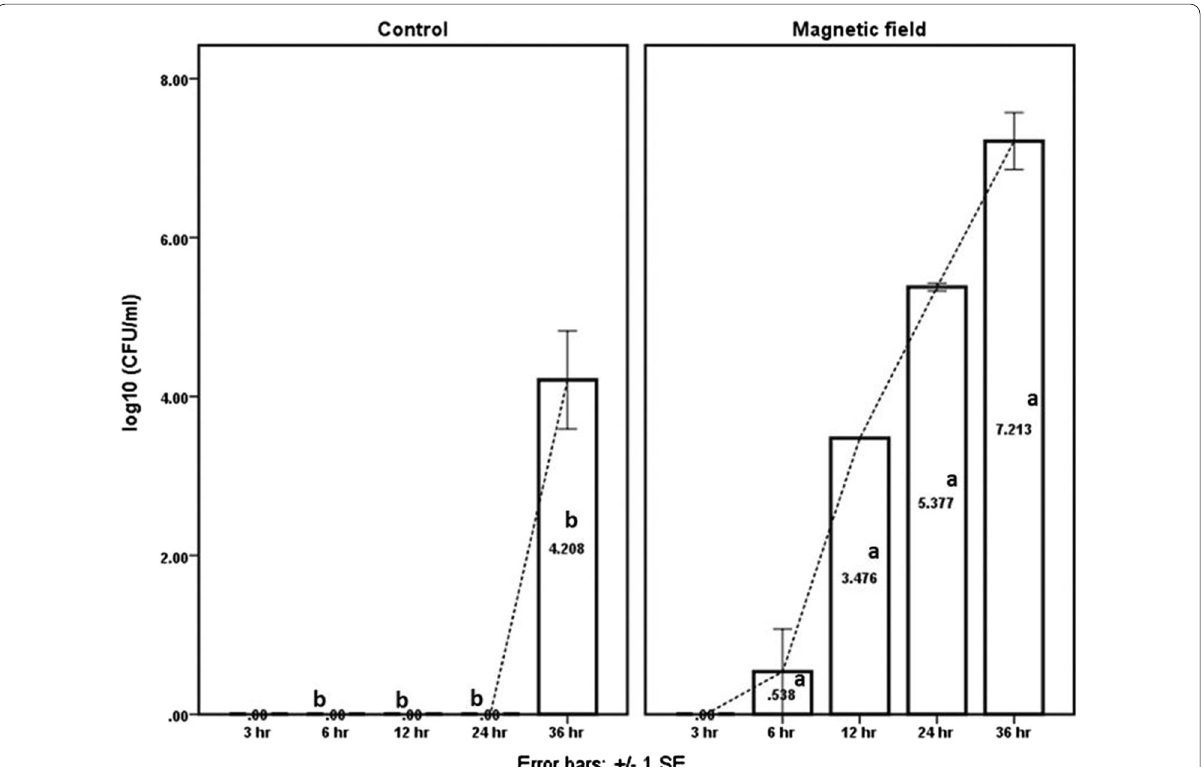
Fig. 2 Effect of magnetic field on Bacillus spore’s germination and propagation. Means are different letters are significantly differing at P